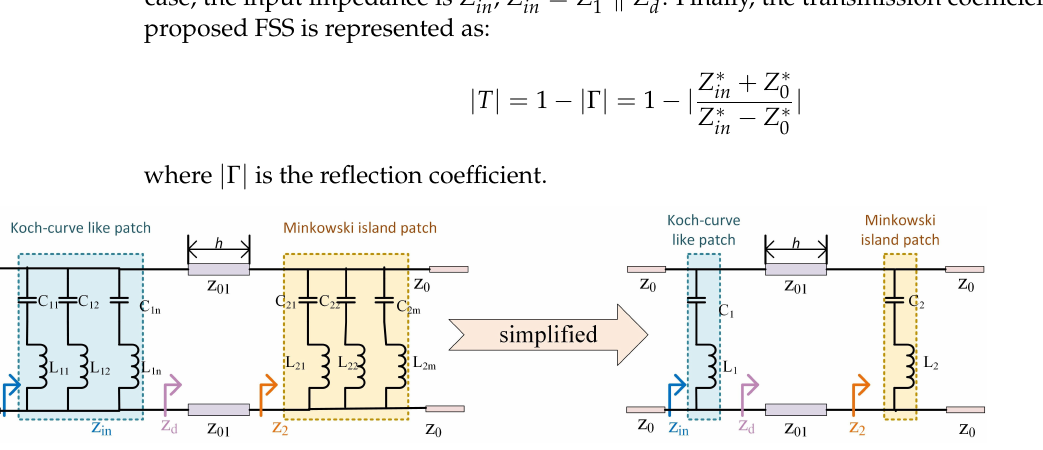
Figure 3. Equivalent circuit of the proposed fractal